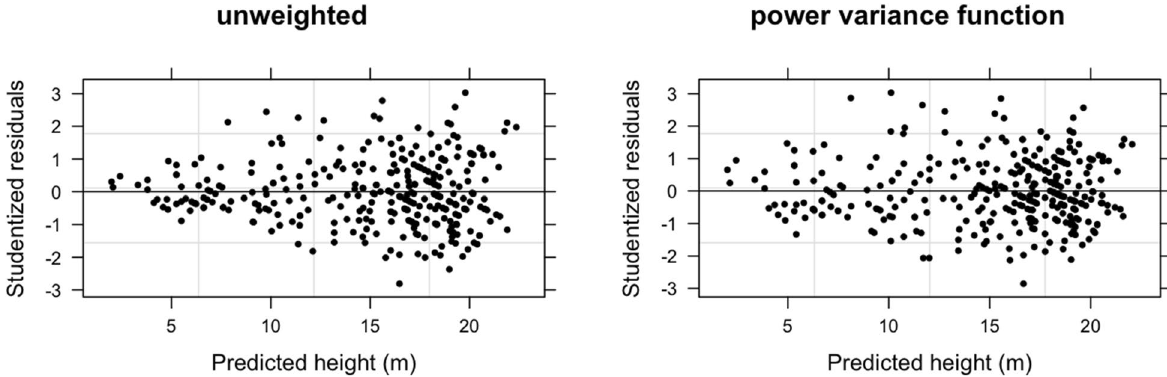
Fig. 16 The plot of studentized residuals against the predicted height for N. pumilio . The studentized residuals were obtained by fitting the simple NLME H–D model for NP without weighting (left) and with power variance function (right)